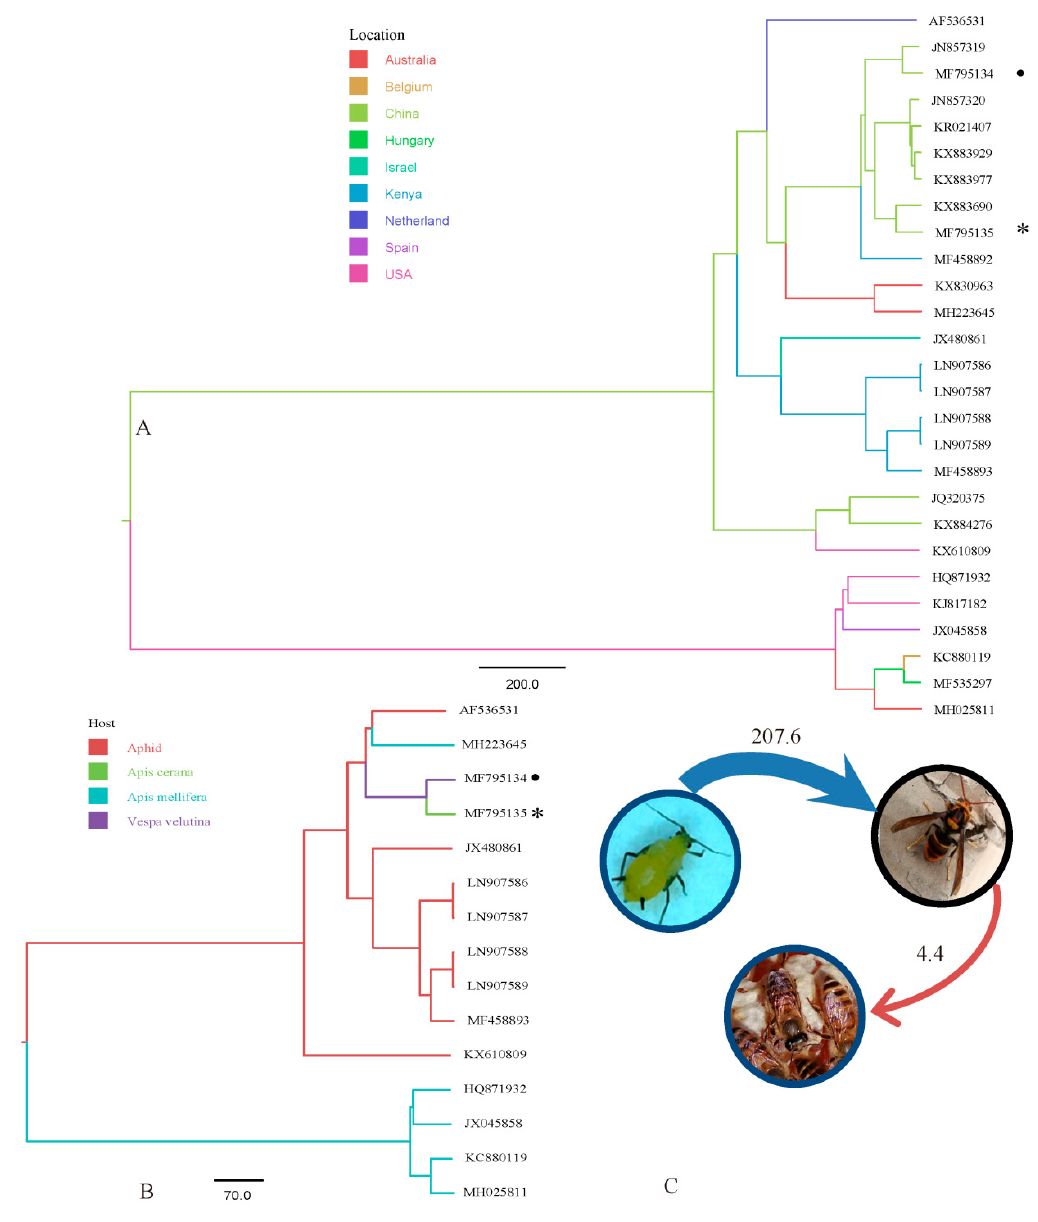
Figure 1. Maximum clade credibility (MCC) phylogeny for RNA dependent RNA polymerase (RdRp) gene of aphid lethal paralysis virus (ALPV) showing inferred host states. ALPV from V. velutina and A. ceranae are indicated by a black dot and asterisk, respectively (GenBank accession no. MF795134, MF795135). ( A ) Tree branches are colored according to the strains originating from different regions. ( B ) Inferred host states were reconstructed in the MCC tree according to different hosts. ( C ) Phylogenetically inferred migration rates for ALPV. The number indicates the Bayes factor (BF). The picture of the aphid is from Reference [13], and the pictures of V. velutina and A. cerana were photographed by Chunsheng Hou. The weight of line indicates the Bayes factor support for migration rates (from thin to thick arrows: BF = 3–10, >100).